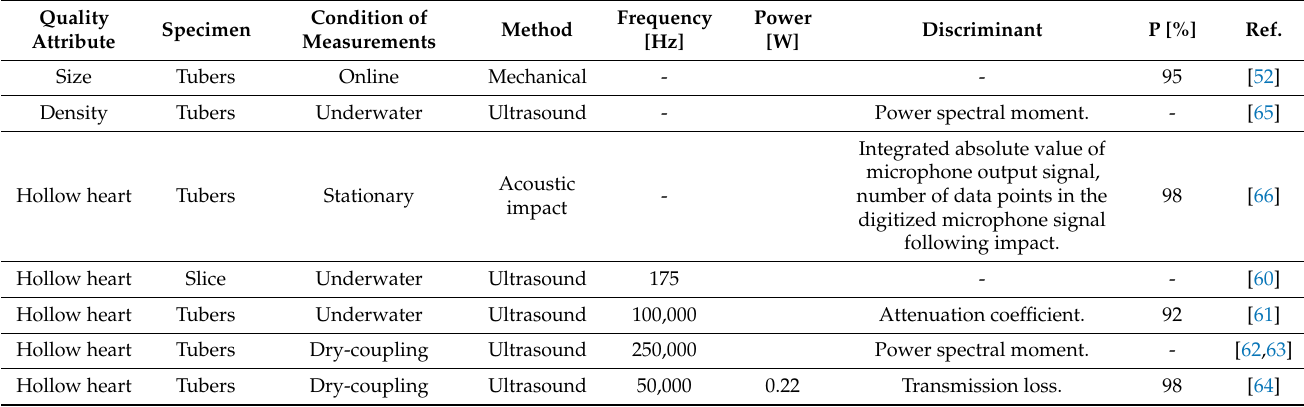
Table 1. Applications of ultrasonic, acoustic mechanical methods in quality assessment of